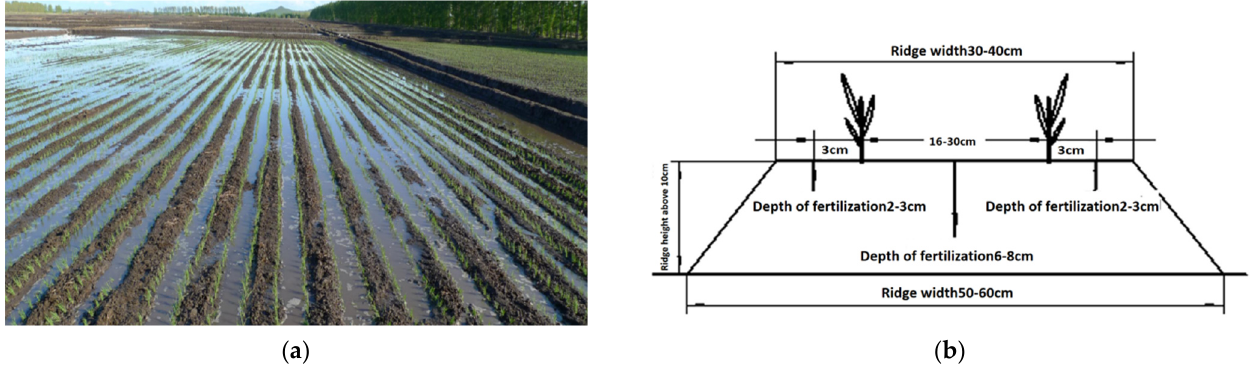
Figure 1. The rice ridge tillage at two fertilizer depths: ( a ) cultivation model field demonstration; ( b ) schematic diagram.